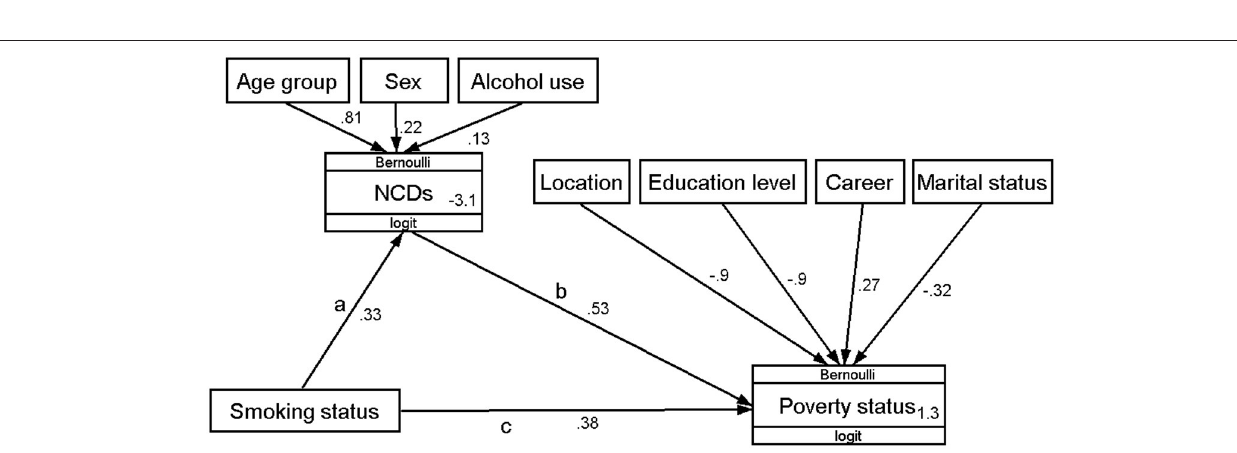
FIGURE 1 | Predictive probabilities of being near poverty across different education levels and smoking status.